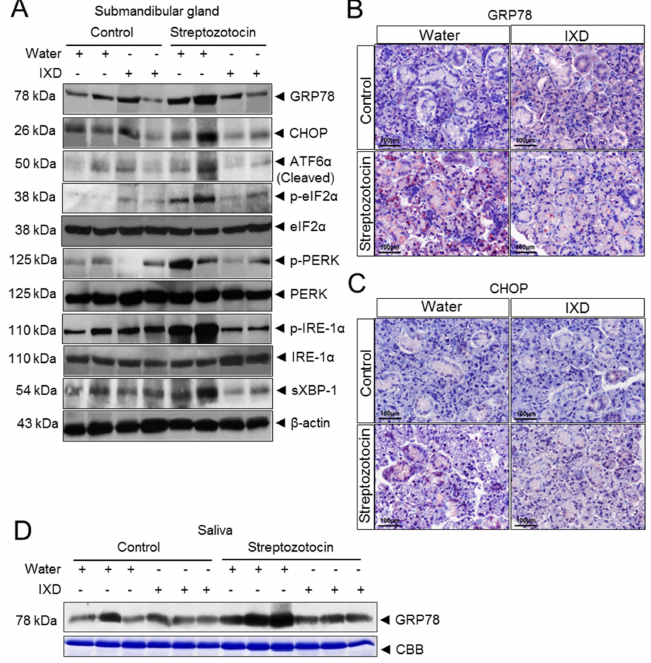
Figure 6. The IXD extract regulates the ER stress response in submandibular gland of diabetic rats. ( A ) Western blot analysis was performed to demonstrate the ER stress response using GRP78, CHOP, ATF6 α , p-eIF2 α , total eIF2 α , p-PERK, total PERK, p-IRE1 α , total IRE1 α , and sXBP-1 antibodies. An equal concentration of protein (30 µ g) was loaded in each lane of the gels. Beta-actin was used as a loading control. The molecular weight of each protein is indicated in kDa; ( B ) immunostaining of GRP78; ( C ) immunostaining of CHOP in the submandibular gland. Magnification: 40 × ; Scale bar: 100 µ m; ( D ) expression of secreted GRP78 in saliva in the indicated groups. Coomassie Brilliant Blue (CBB) staining was performed as a control for equal protein